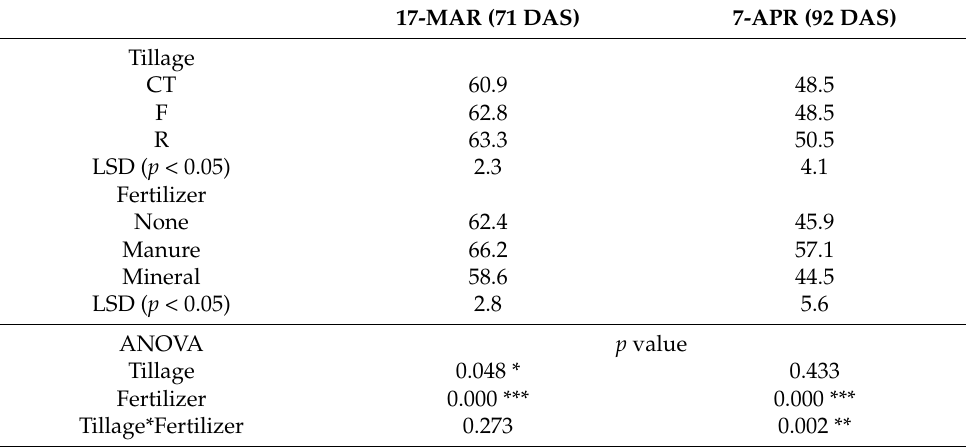
Table 6. Averages and results of ANOVA for SPAD in